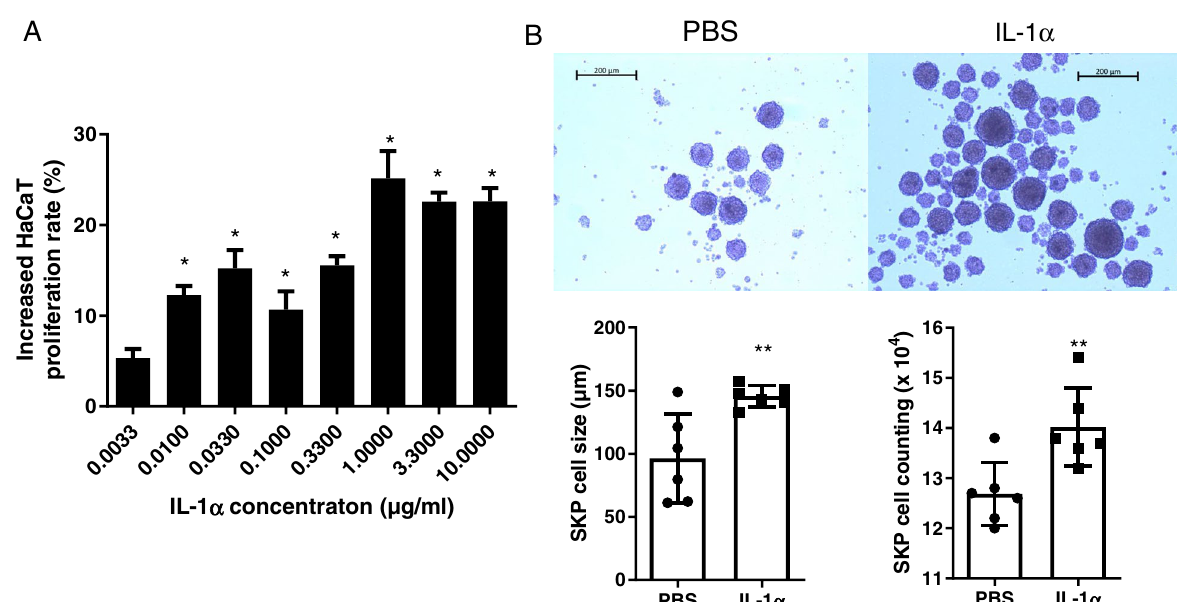
Fig. 9 A IL-1α increased HaCaT cells proliferation ( n numbers. ** P <